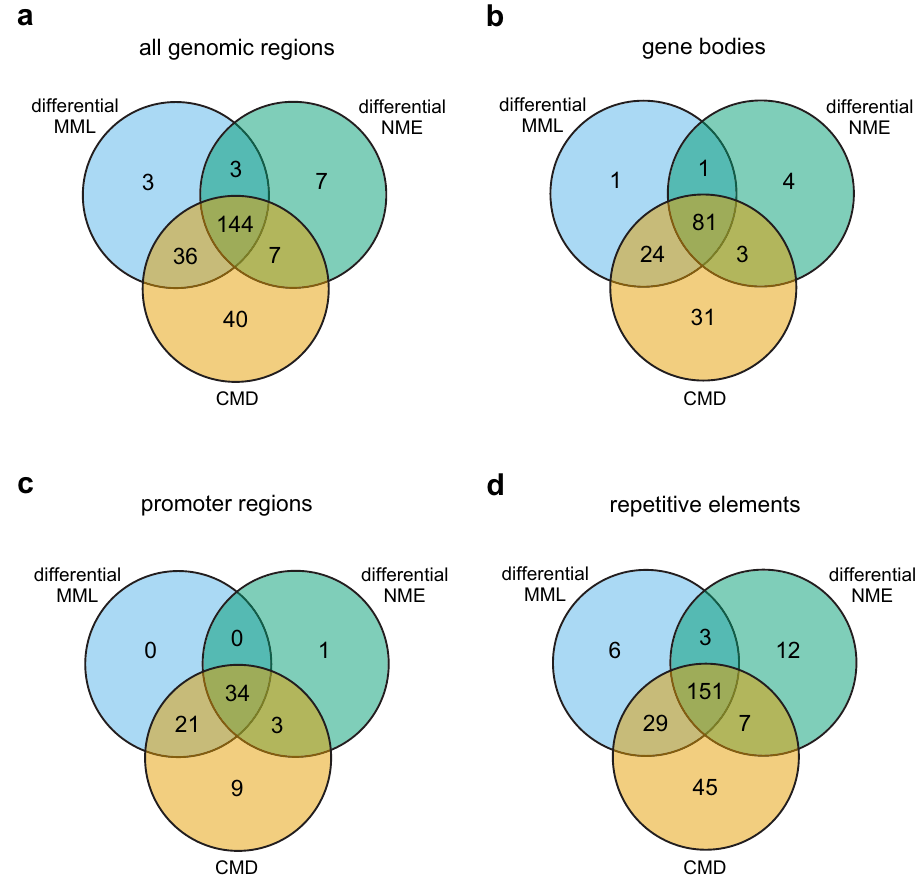
Figure 4. Methylation discordance and analysis regions in the targeted breast normal/cancer comparison. ( a ) Venn diagram showing the number of analysis regions overlapping all genomic regions examined that exhibited significant differences in mean methylation level (MML) and normalized methylation entropy (NME), as well as significant discordance in the probability distribution of methylation quantified by the coefficient of methylation divergence (CMD). ( b ) Venn diagram of significantly dysregulated analysis regions that overlap gene bodies. ( c ) Venn diagram of significantly dysregulated analysis regions that overlap promoter regions. ( d ) Venn diagram of significantly dysregulated analysis regions that overlap known repetitive